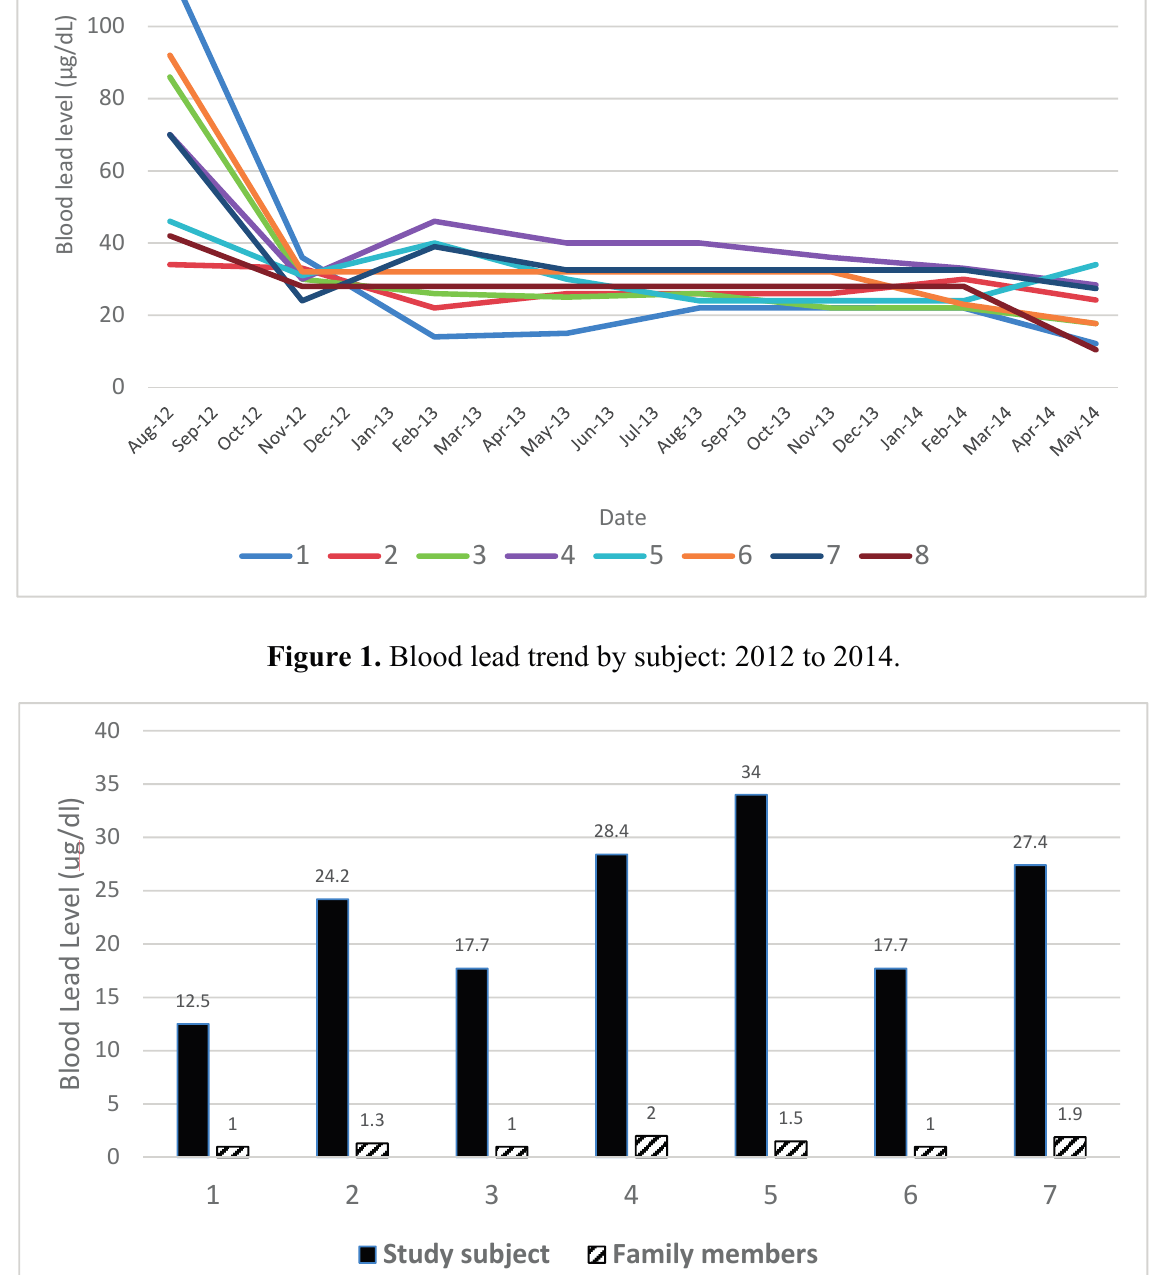
Figure 2. Comparison of current (May 2014) blood lead levels in participants and their family